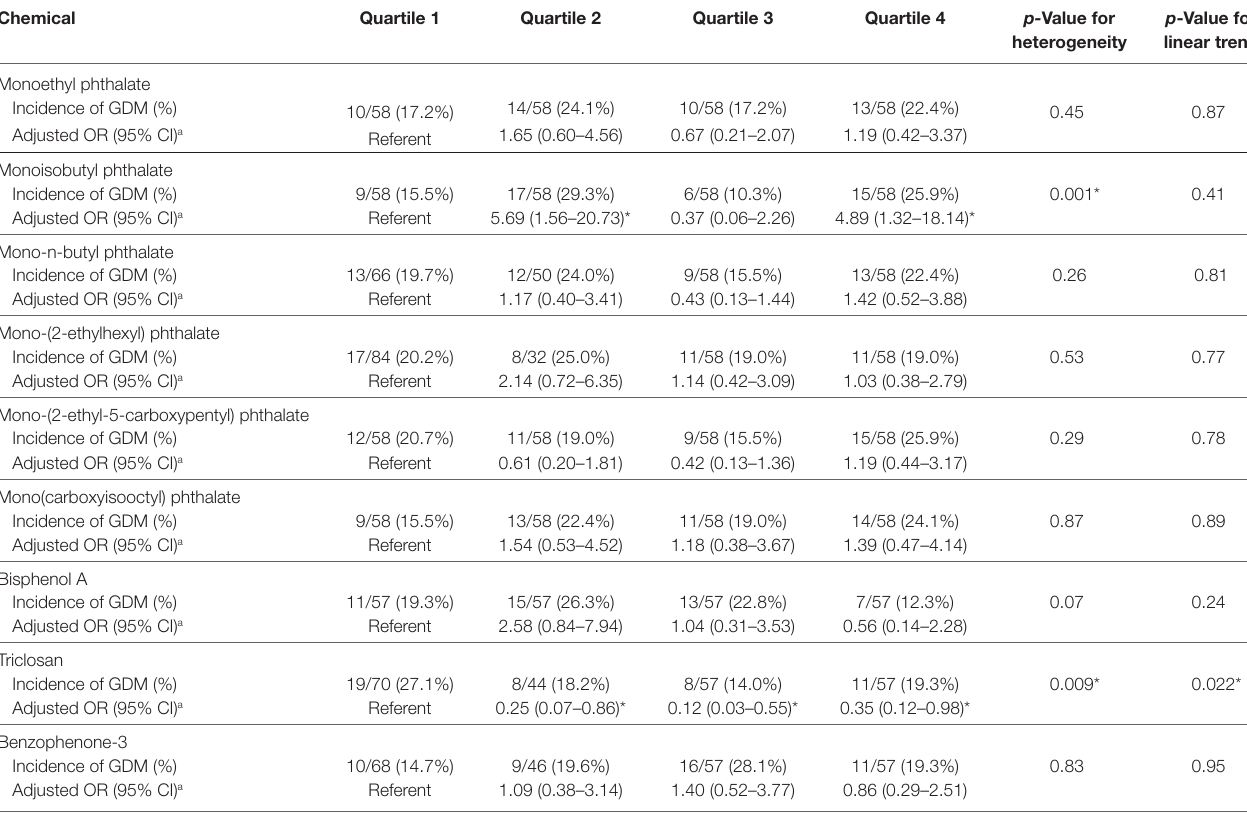
Table 4 | Adjusted odd ratios and 95% CIs of incident gestational diabetes mellitus (GDM) by category of concentrations of the different